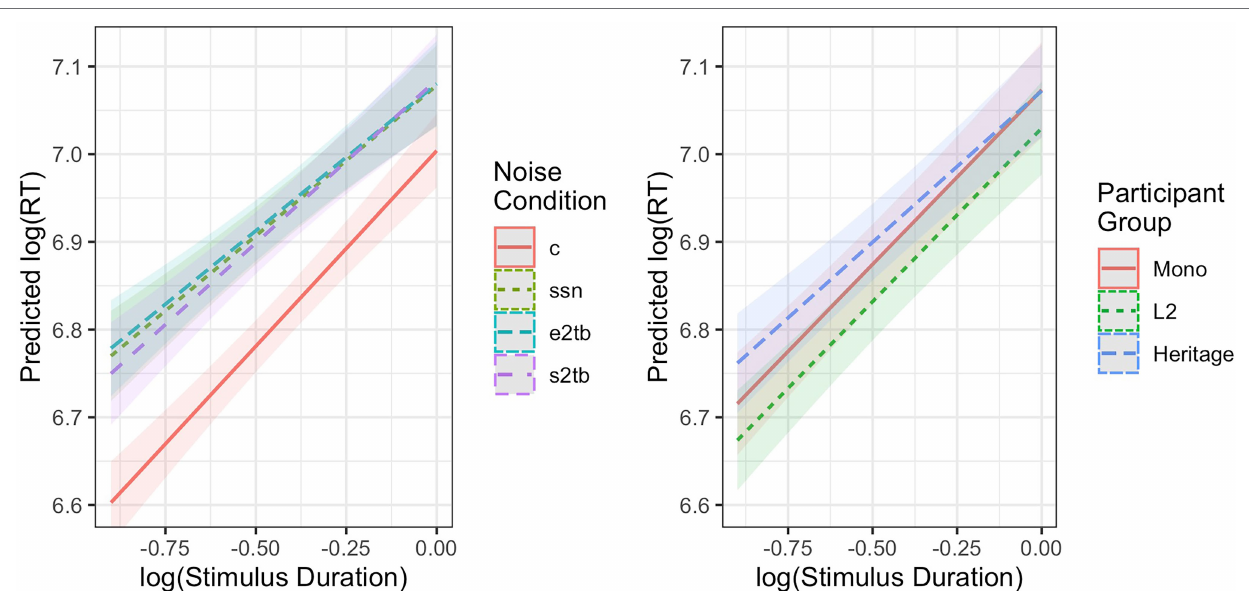
FIGURE 2 | Predicted response times (estimated marginal trends with prediction intervals) showing effects of stimulus duration across noise conditions and participant groups, using the fitted model from Table 4 . (c = clear, ssn = speech-shaped noise, e2tb = English two-talker babble, and s2tb = Spanish two-talker babble).